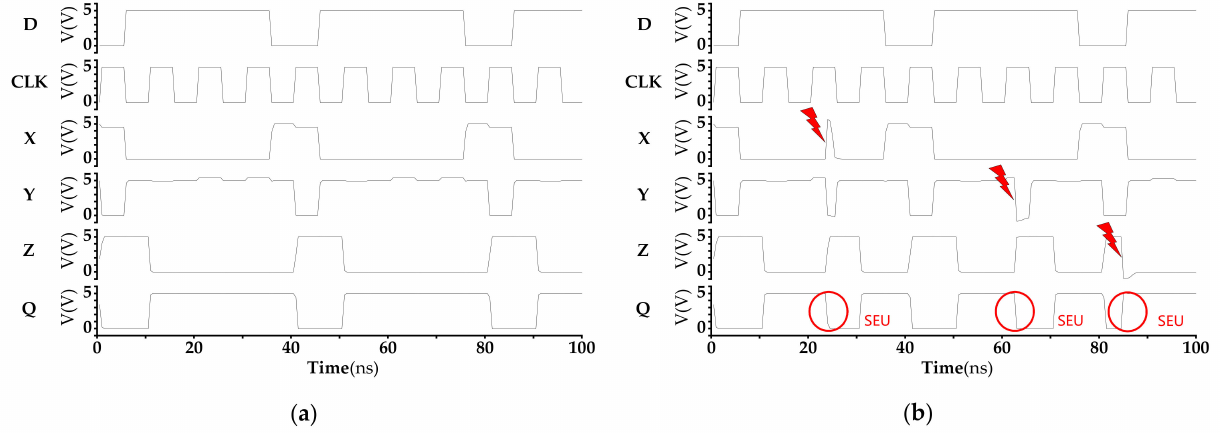
Figure 17. TSPC-DICE: ( a ) simulation waveform of TSPC-DICE without SETs; ( b ) simulation wave- form of TSPC-DICE with